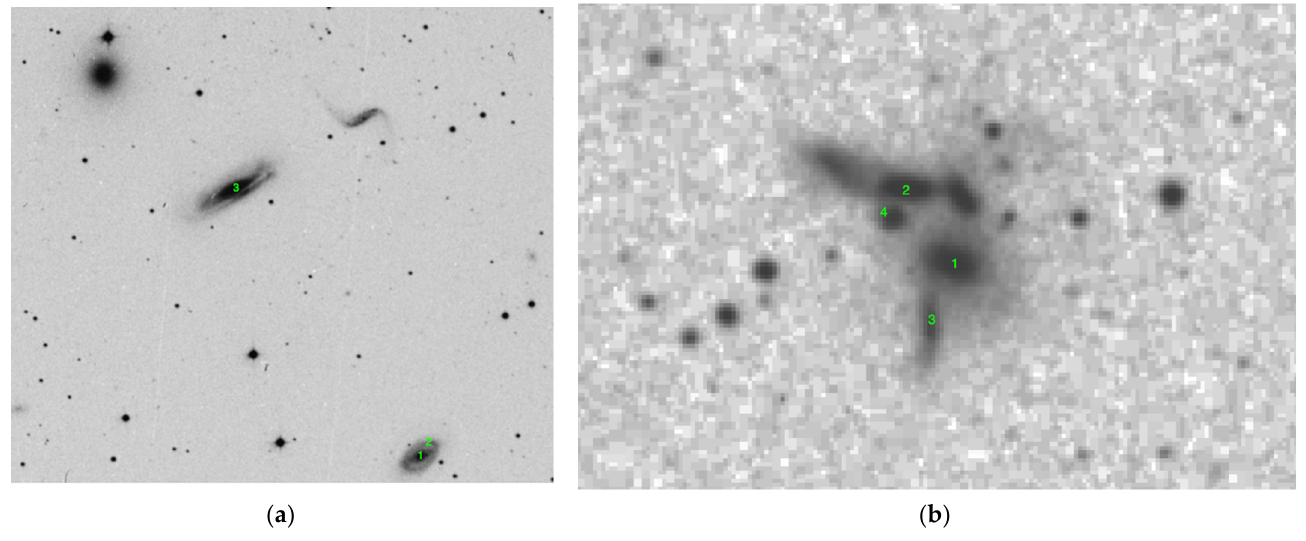
Figure 3. ( a ) XMM X-ray sources coincident with the galaxies on DSS image of HCG 44. ( b ) Chandra X-ray point sources on DSS image of HCG 79.